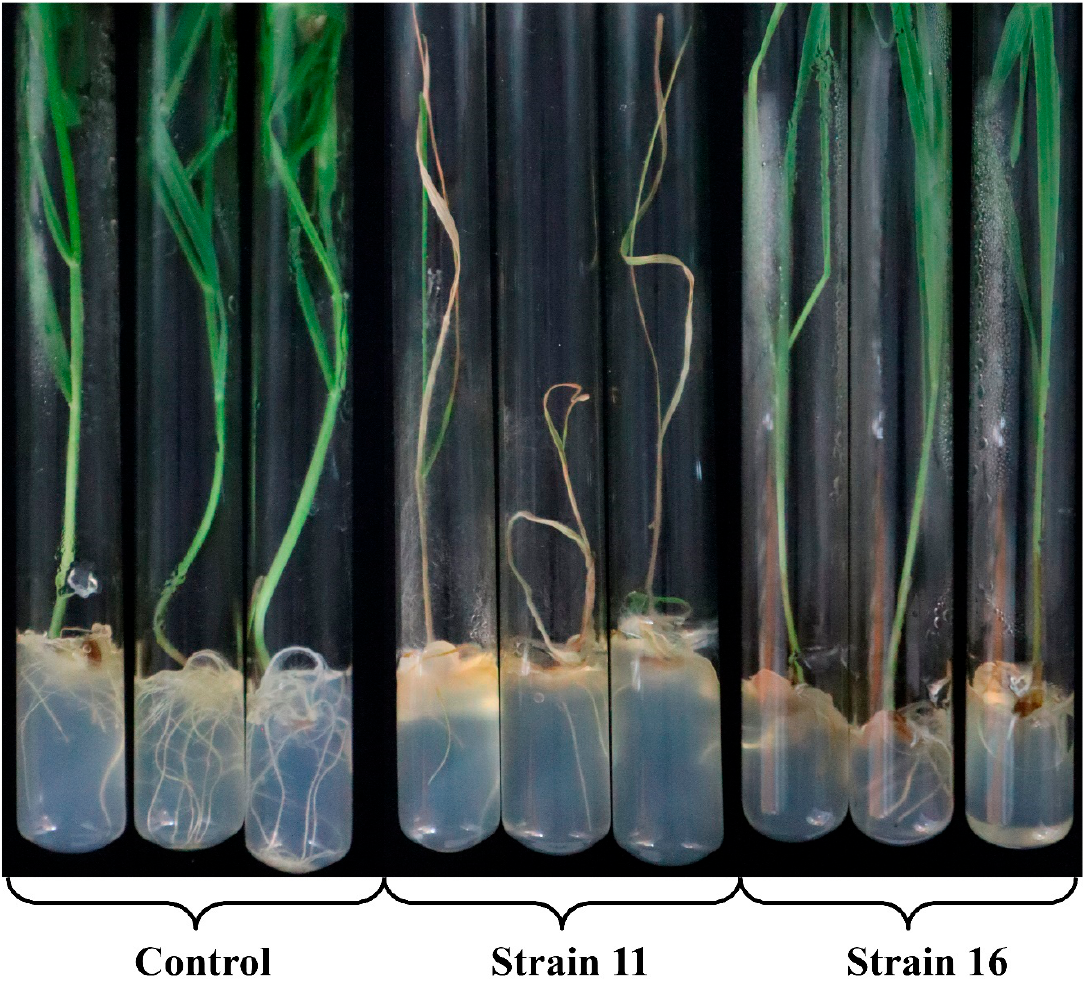
Figure 12. Rye plants (cultivar Ogonek) infected with the isolated Microdochium nivale strains (11 and 16). Control—noninfected plants. The presented photos demonstrate the infection (20th day) caused by one of the highly virulent strains (11), which was associated with a severe stem and leaf necrosis and reduction of root biomass, and by one of the moderately virulent strains (16), which did not cause severe damage to the aboveground plant parts but strongly reduced root biomass. Photos of the plants infected by all of the isolated strains are given in Figure S1 (Supplementary Materials). Table 1. Mean values of the assessed parameters of the rye plants infected by the isolated Microdochium nivale strains of different clusters: 1. highly virulent, 2. moderately virulent, 3. low virulent, and 4. avirulent. The following parameters of the plants were analyzed: number of roots, number of leaves, root length, shoot length, the weight of roots of 10 plants, the weight of shoots of 10 plants, the weight of 10 plants, the percentage of plants with brownish roots, the percentage of plants with stem necrosis, and the percentage of plants with leaf necrosis. Clusters that do not share the same letter (given in brackets) have significantly different means in pairwise comparison (Duncan’s multiple range test).